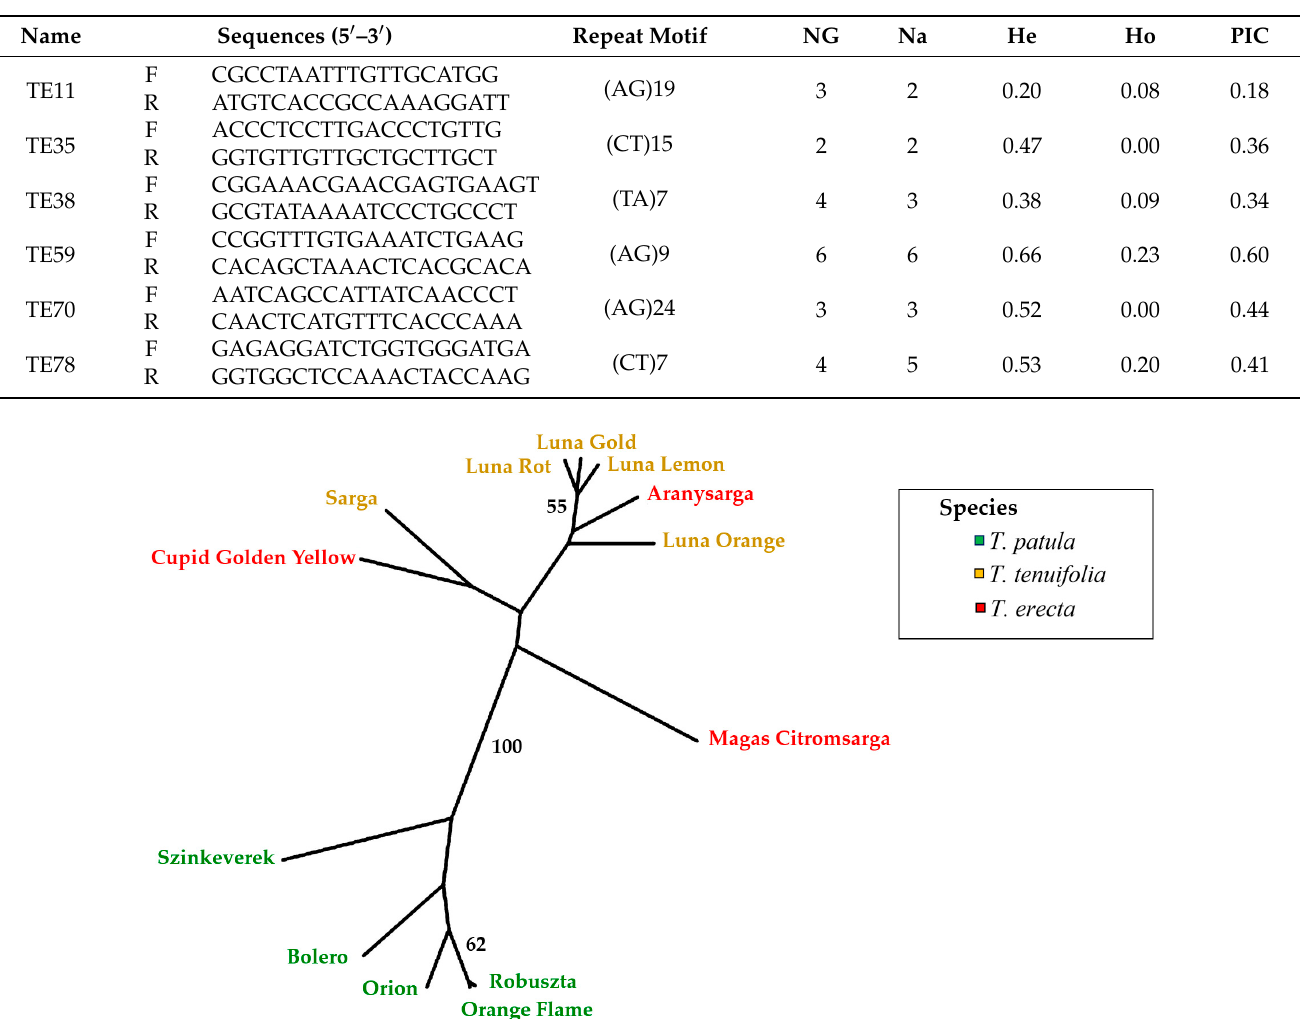
Table 6. SSR markers, forward (F) and reverse (R) probes, repeat motif, number of genotypes (NG), number of alleles per locus (Na), expected heterozygosity (He), observed heterozygosity (Ho) and polymorphism information content (PIC) in the set of 13 Tagetes cultivars.